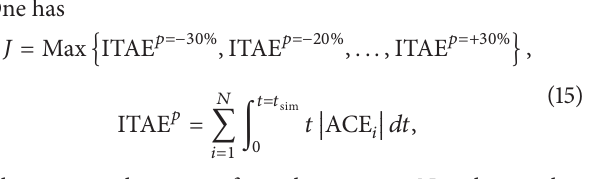
frequency control for PID in each control area (in both case studies)